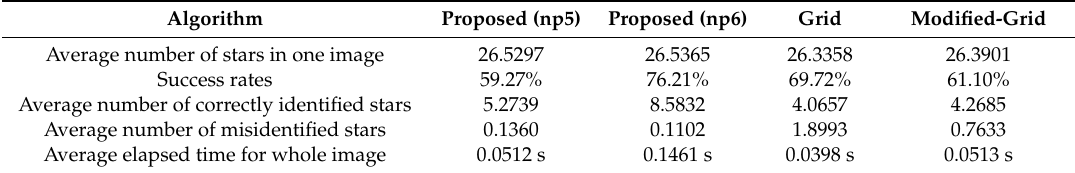
Table 10. Case 3-1: Comparing results of star identification methods in 12.09 ◦ × 12.09 ◦ FOV.